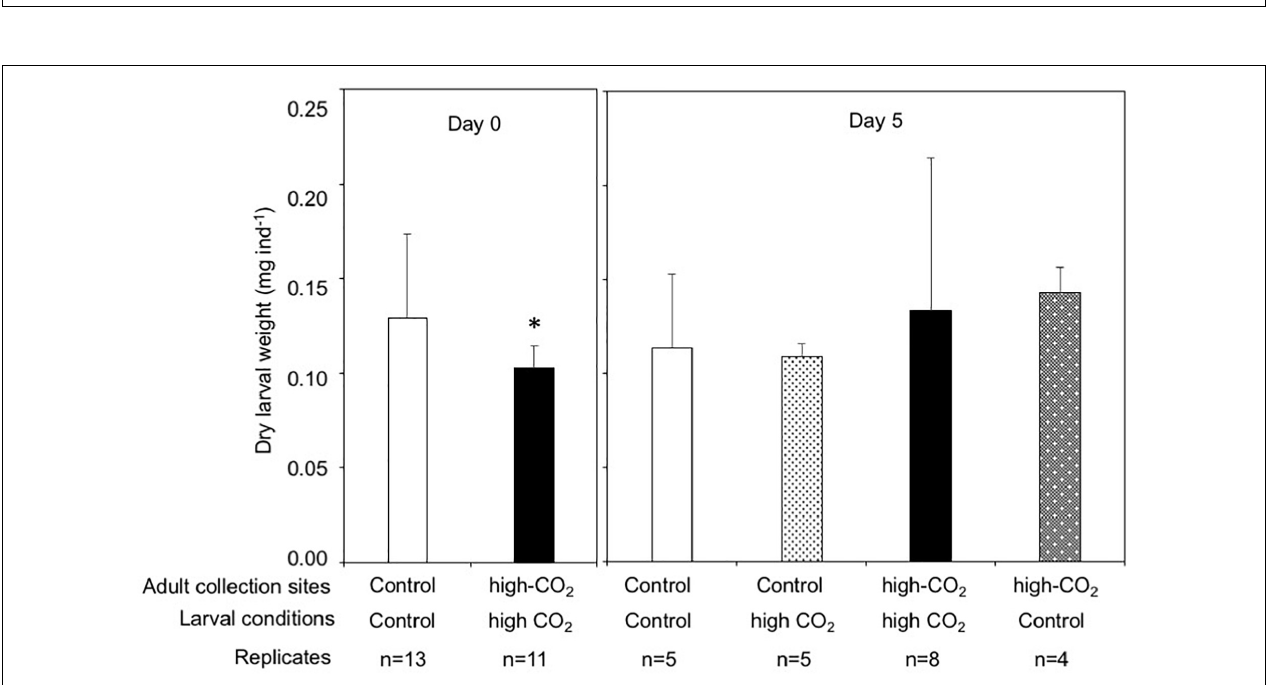
FIGURE 4 | Dry weight of Pocillopora acuta larvae released from adult collected at control (white bar) and high-CO 2 (black bar) sites at Day 0, and at Day 5 after being reciprocally reared under control or high CO 2 conditions. At Day 0, differences among larvae from control and high-CO 2 sites were compared by Wilcoxon rank test, and asterisk shows significant differences. At Day 5, dry weight did not show significant differences among larvae originating from control and CO 2 parents, or among larvae cultured at control and CO 2 conditions. The replicate number are shown as n in the graph. Average ± SD.